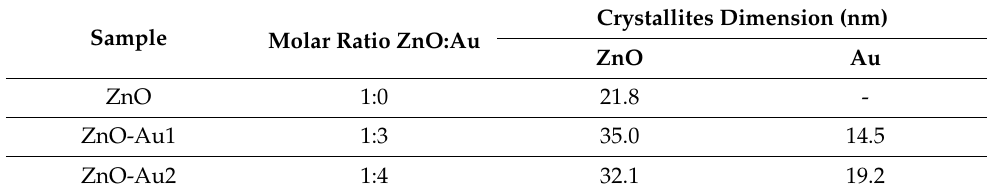
Table 1. The synthetic details and crystallite size for the pure ZnO nanoparticles and the ZnO-Au nanocomposites.